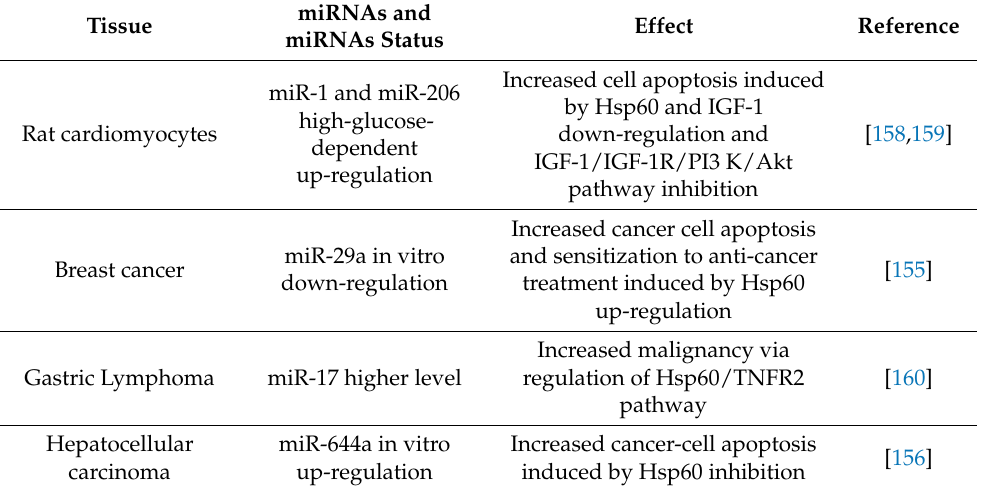
Table 3. Examples of miRNAs involved in Hsp60